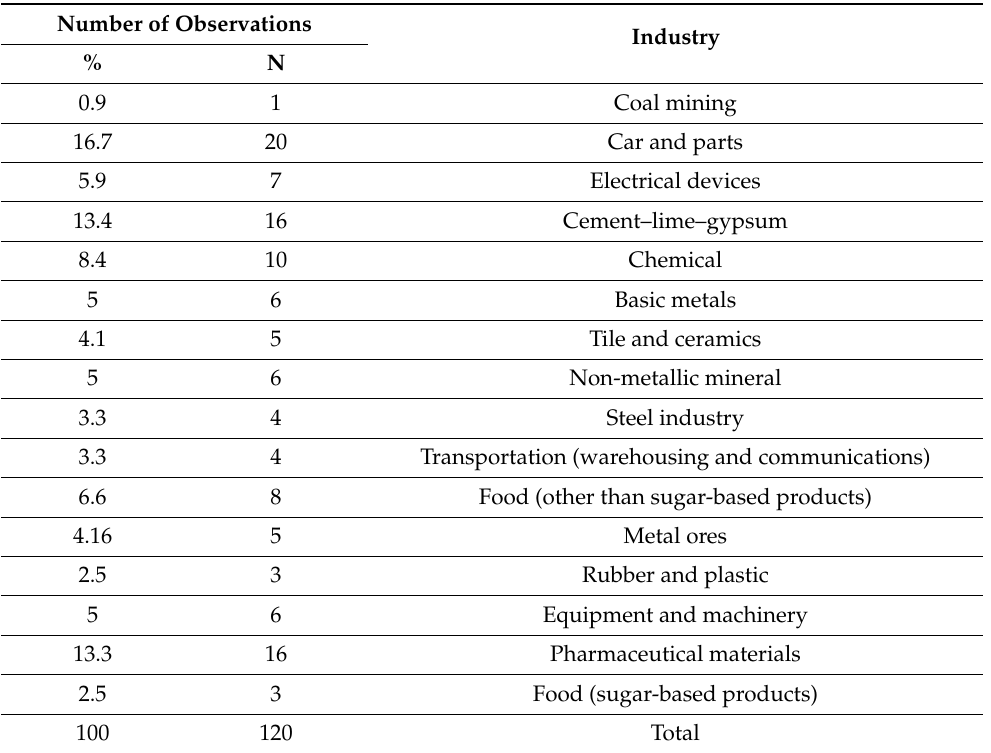
Table 2. Sample companies by industry.